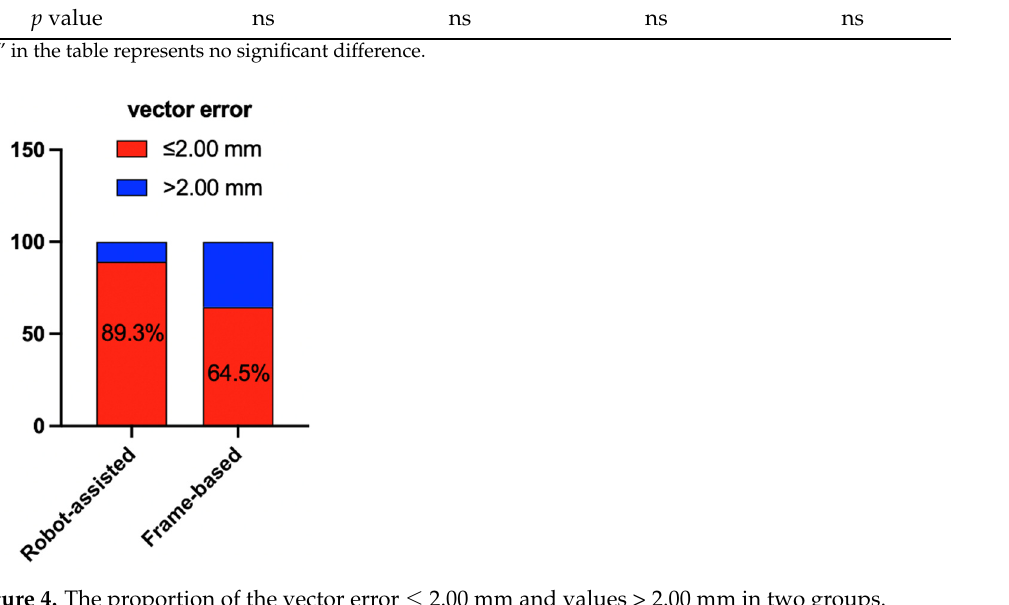
Table 1. Contact deviations and vector error of final leads from the planned position (mm) in two groups. ∆ x ∆ y ∆ z m m m Vector Error Robot-assisted 0.79 ± 0.65 0.80 ± 0.49 0.64 ± 0.48 1.52 ± 0.53 Frame-based 0.99 ± 0.79 1.01 ± 0.51 0.64 ± 0.54